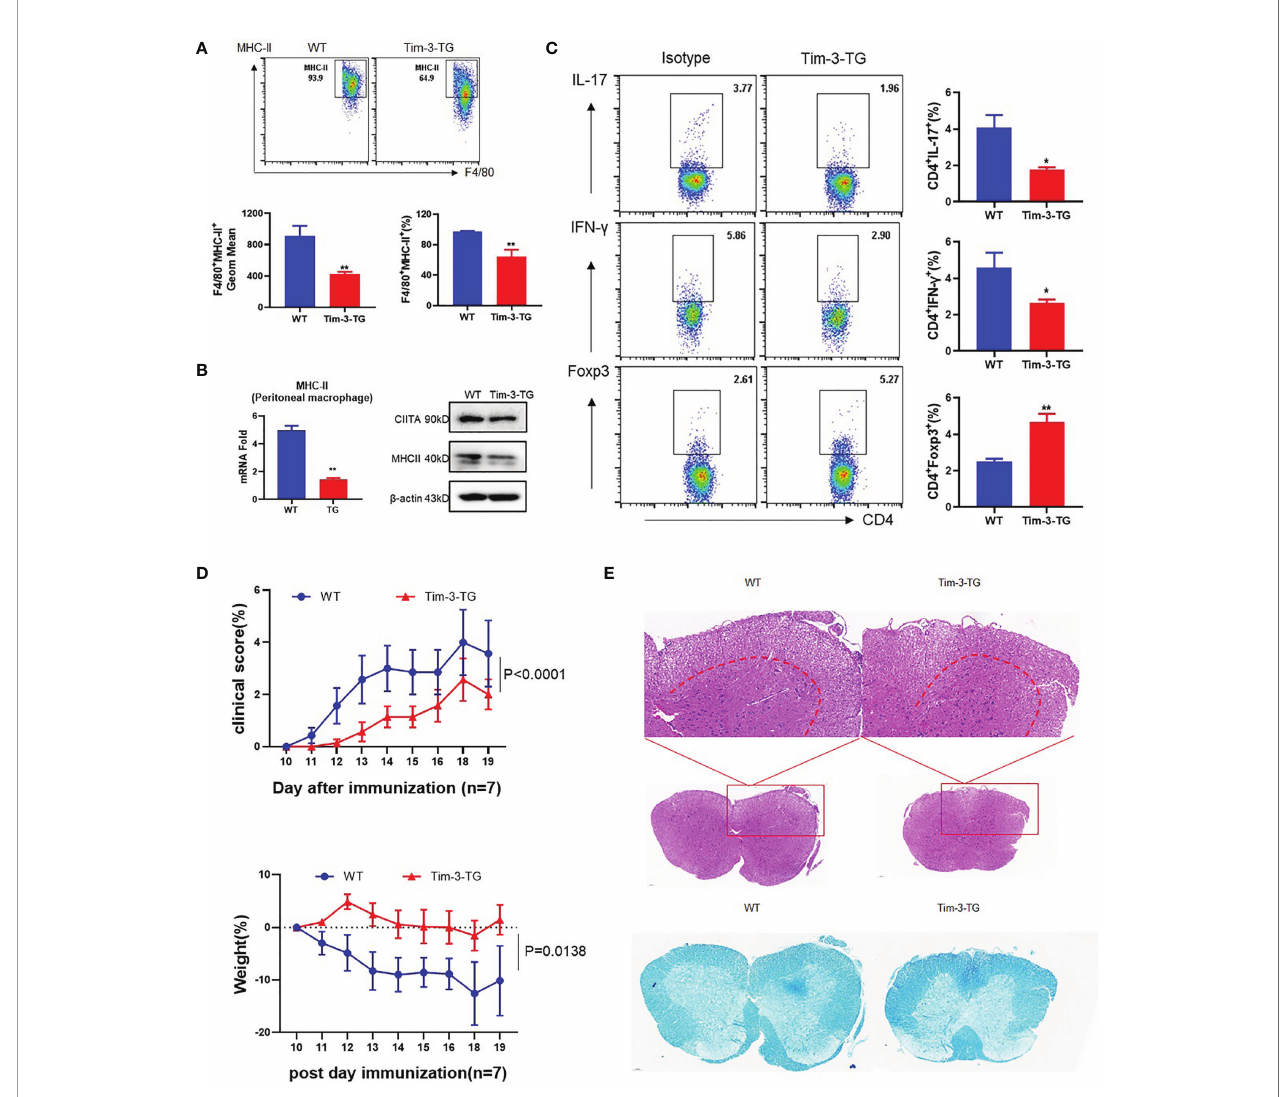
FIGURE 4 | Tim-3 inhibits MHC-II and ameliorates the EAE mouse model. MOG was emulsi fi ed into CFA, WT, and Tim-3-TG mice (n = 8) were immunized subcutaneously, and pertussis toxin (500 ng/mouse) was injected intraperitoneally at 2 and 48 h after immunization. On the 20th day after immunization, the mouse spinal cords, peritoneal macrophages, and spleens were harvested. (A) Flow cytometry was used to detect the expression of MHC-II on the surface of macrophages. The percentage of MHC-II and the GeoMean were counted (mean ± SD, n = 6 – 8), (B) and the expression level of MHC-II was detected by RT-PCR (mean ± SD, n = 6) and Western blotting. (C) Flow cytometry was used to detect the activation levels of IL-17 + CD4 + T, IFN- g + CD4 + T, and Foxp3 + CD4 + Tcells in splenic lymphocytes (mean ± SD, n = 8 – 10). (D) The weight and clinical scores of the EAE mice were recorded from the 10th day. (E) The mouse spinal cord tissue was isolated and stained with HE and LFB (*p < 0.05; **p <